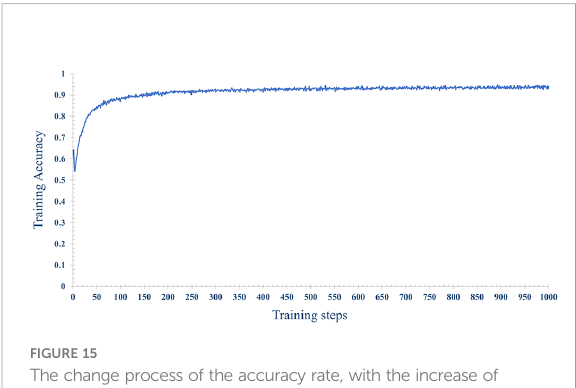
FIGURE 15 The change process of the accuracy rate, with the increase of training epochs, when the number of nodes is 5 in the hidden layer.